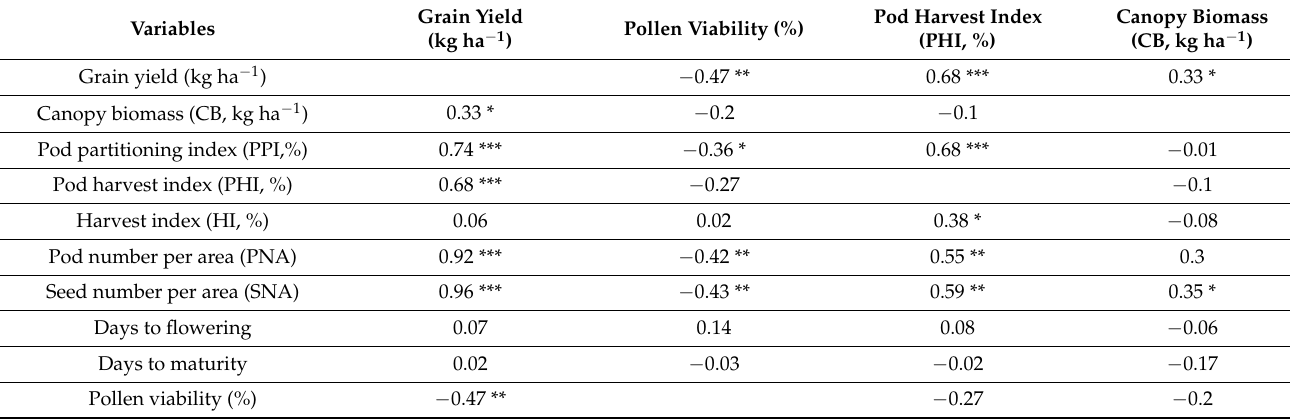
Table 1. Correlation coefficients (r) between grain yield, pollen viability , pod harvest index, canopy biomass, leaf temperature differential and other plant attributes of 41 bean genotypes grown under conditions of acid soil and high temperature stress.